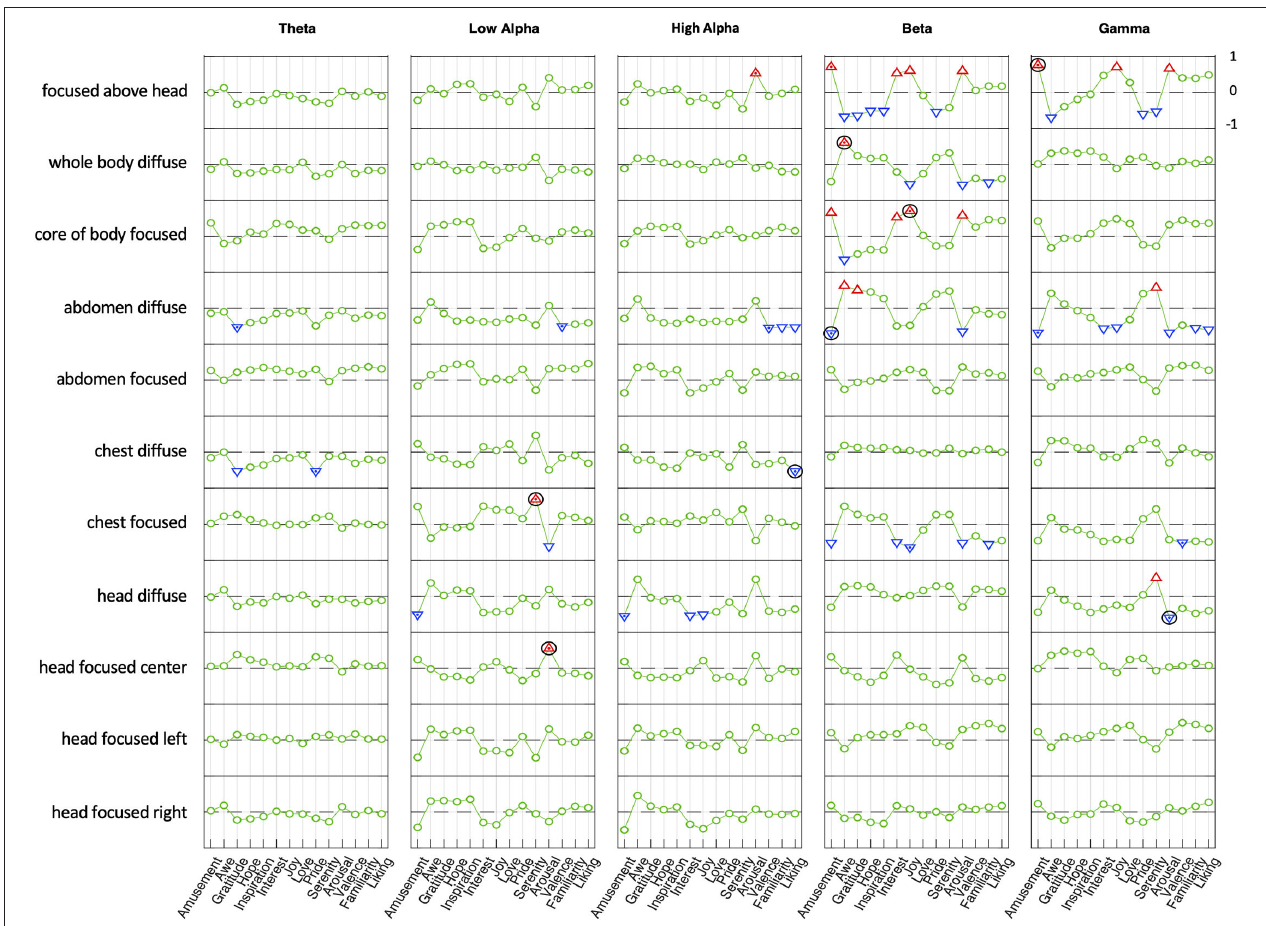
FIGURE 7 | Correlation between average power spectra (differences from non-Null mean) and emotional correlation topography in Hu et al. (2017) in five frequency bands. The abs[correlation] ≥ 0.5 are indicated by triangles. Across 32 scalp locations, correlations ≥ 0.5 are significant at p ≤ 0.002. The maximum within-band abs[correlation] above this threshold is marked with a dot. The frequency band with maximum correlation for each state is marked with a black